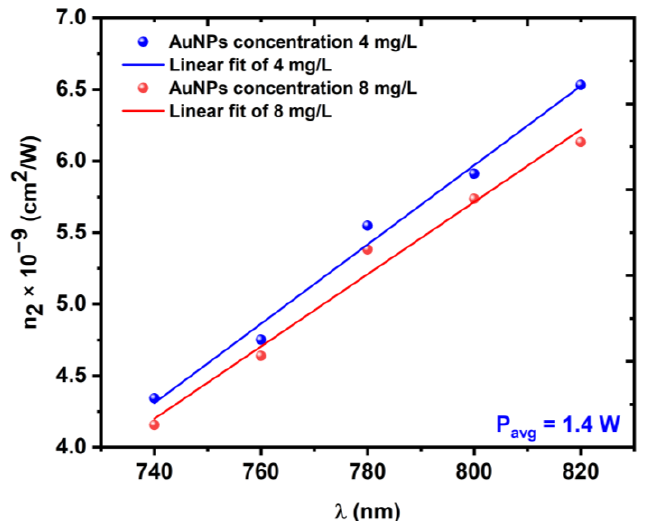
Figure 14. Variations in the NL refractive index n 2 as a function of the excitation wavelength λ at a constant average power of 1.4 W.